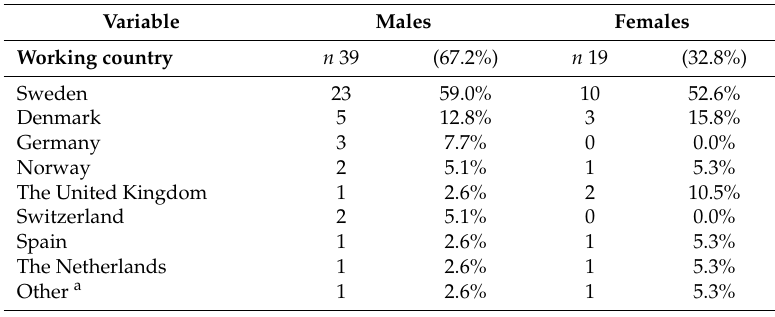
Table 1. Individual and external characteristics of respondents ( n =